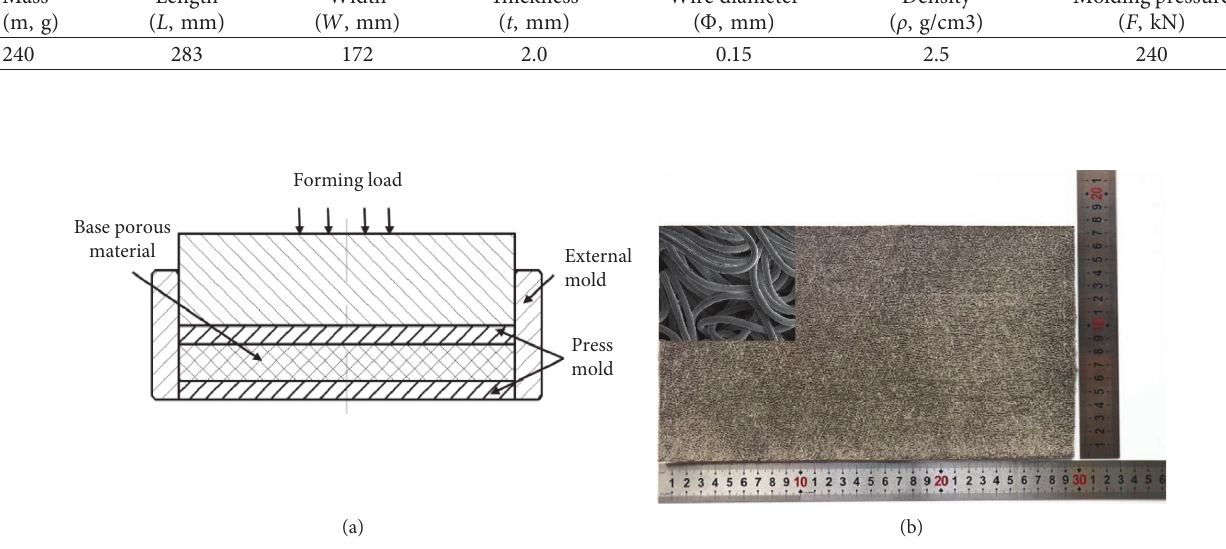
Figure 2: (a) The compression forming tools and (b) the fabricated metal rubber